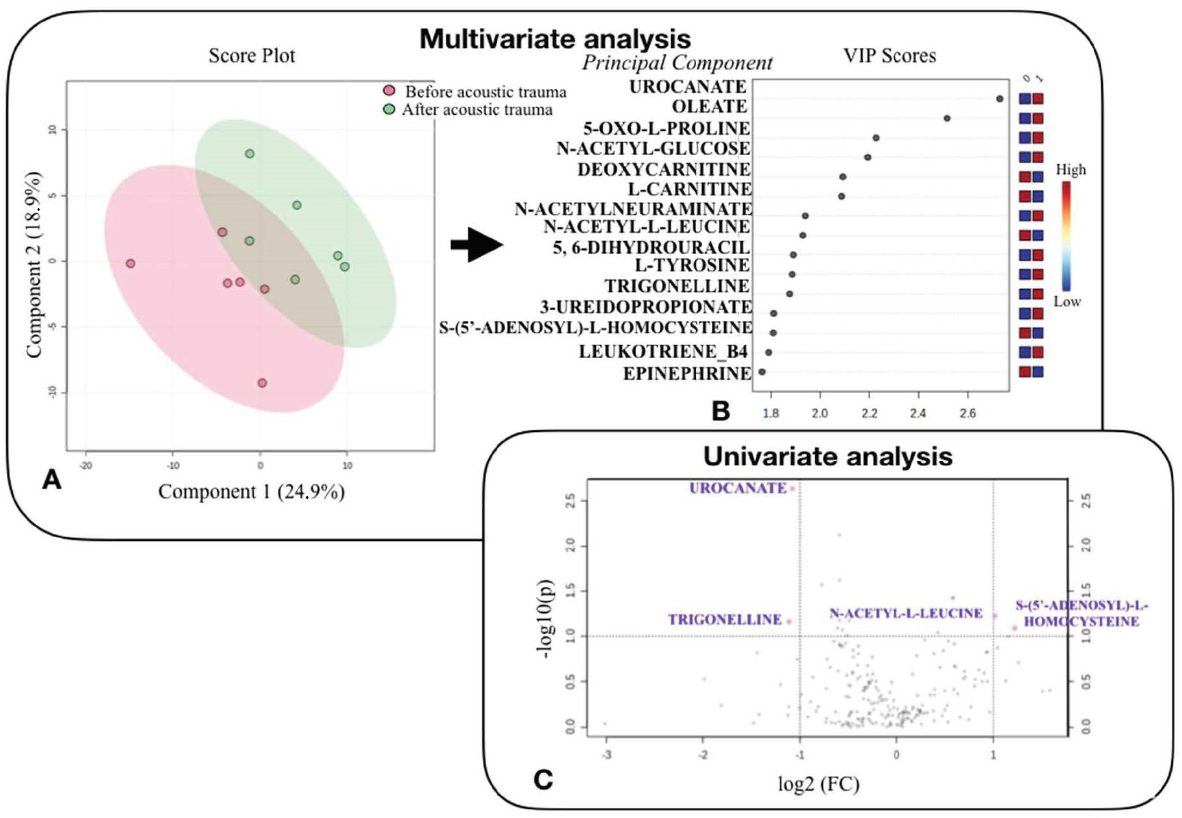
Figure 2. Statistical analysis to compare the metabolomic profile of perilymph fluid from sheep before and after acoustic trauma. ( A ): Multivariate analysis using partial least squares discriminant analysis (PLSDA) to distinguish metabolomic profile of perilymph fluid from sheep before (red circles) and after acoustic trauma (green circles). Components 1 and 2 represent a linear combination of relevant metabolites expressing maximum variance. ( B ): The rank of different metabolites (top 15) identified by PLSDA according to the VIP (Variable Influence of Projection) score on the left. The colored boxes on the right indicate the relative concentrations of the corresponding metabolite in each group studied. ( C ): Univariate analysis via a plot based on fold change and p -value, highlighting 4 metabolites. The volcano plot based on the comparison between NH control and NIHL perilymph samples, highlighting metabolites characterized by a FC > 1.2 concentration ratio and a t-test (y) < 0.1 (pink points). Note that fold changes and p -values are log transformed. The further away from (0.0) position, the more important the feature.